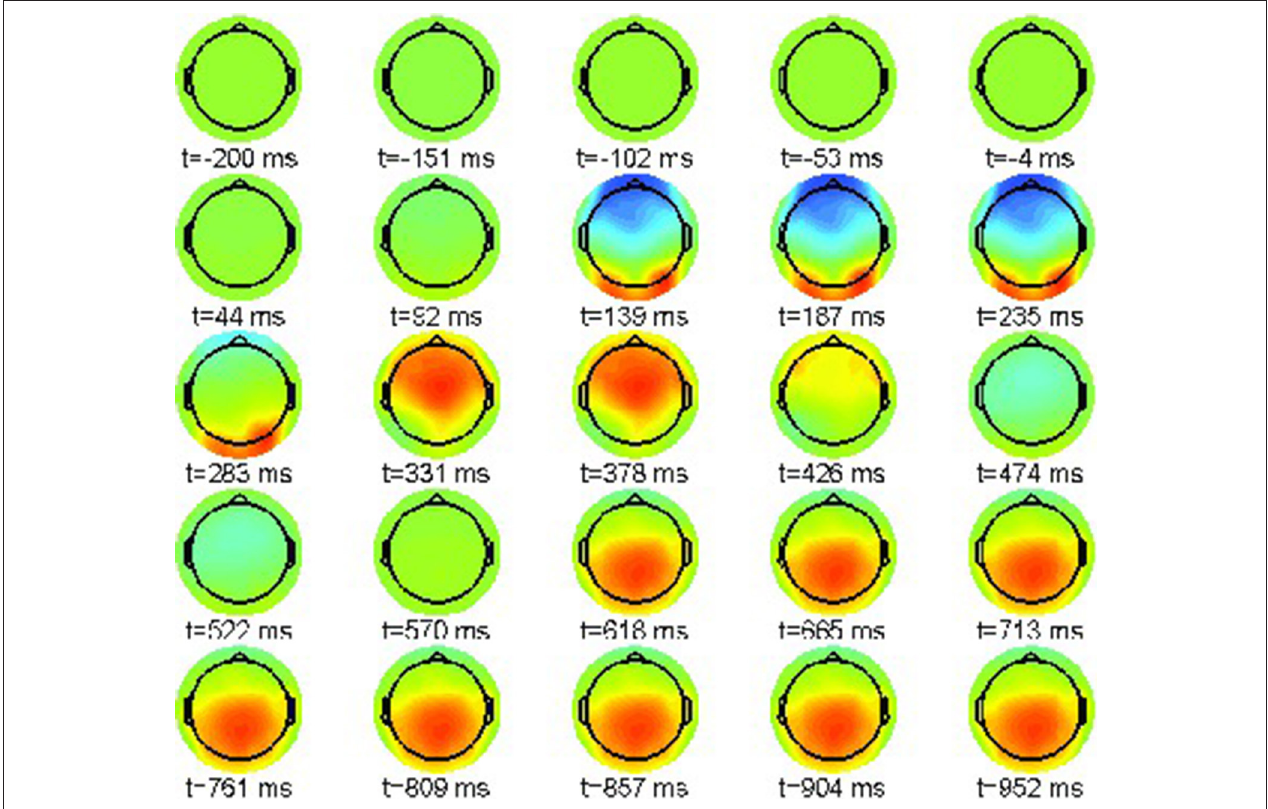
FIGURE 9 | Snapshot sequence of neural field scalp topographies for difference potential, cf. movie model.gif in Supplementary Material.